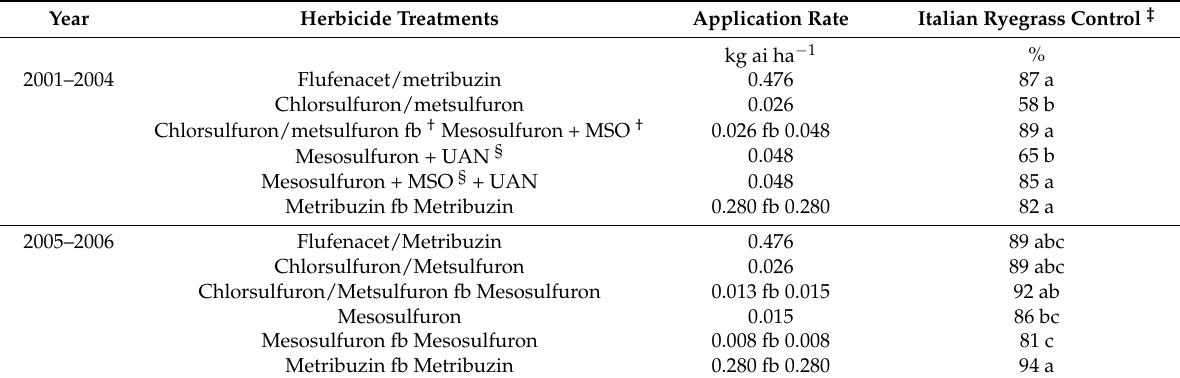
Table 5. Italian ryegrass control as affected by herbicide treatments used from 2001 to